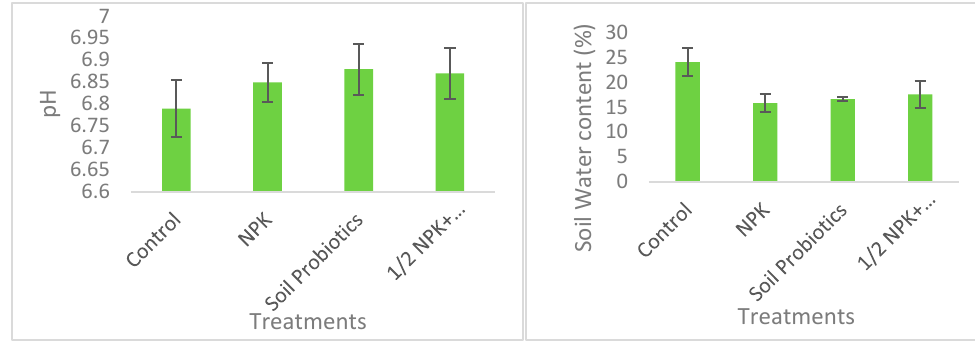
Figure 1. Study map of the experimental site.